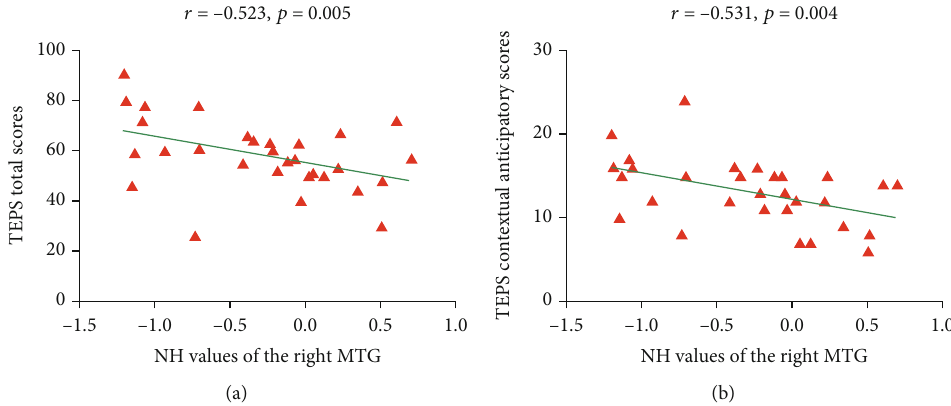
Figure 5: (a) Correlation between the NH values of the right middle temporal gyrus and the TEPS total scores in melancholic patients. (b) Correlation between the NH values of the right middle temporal gyrus and the TEPS contextual anticipatory scores in melancholic